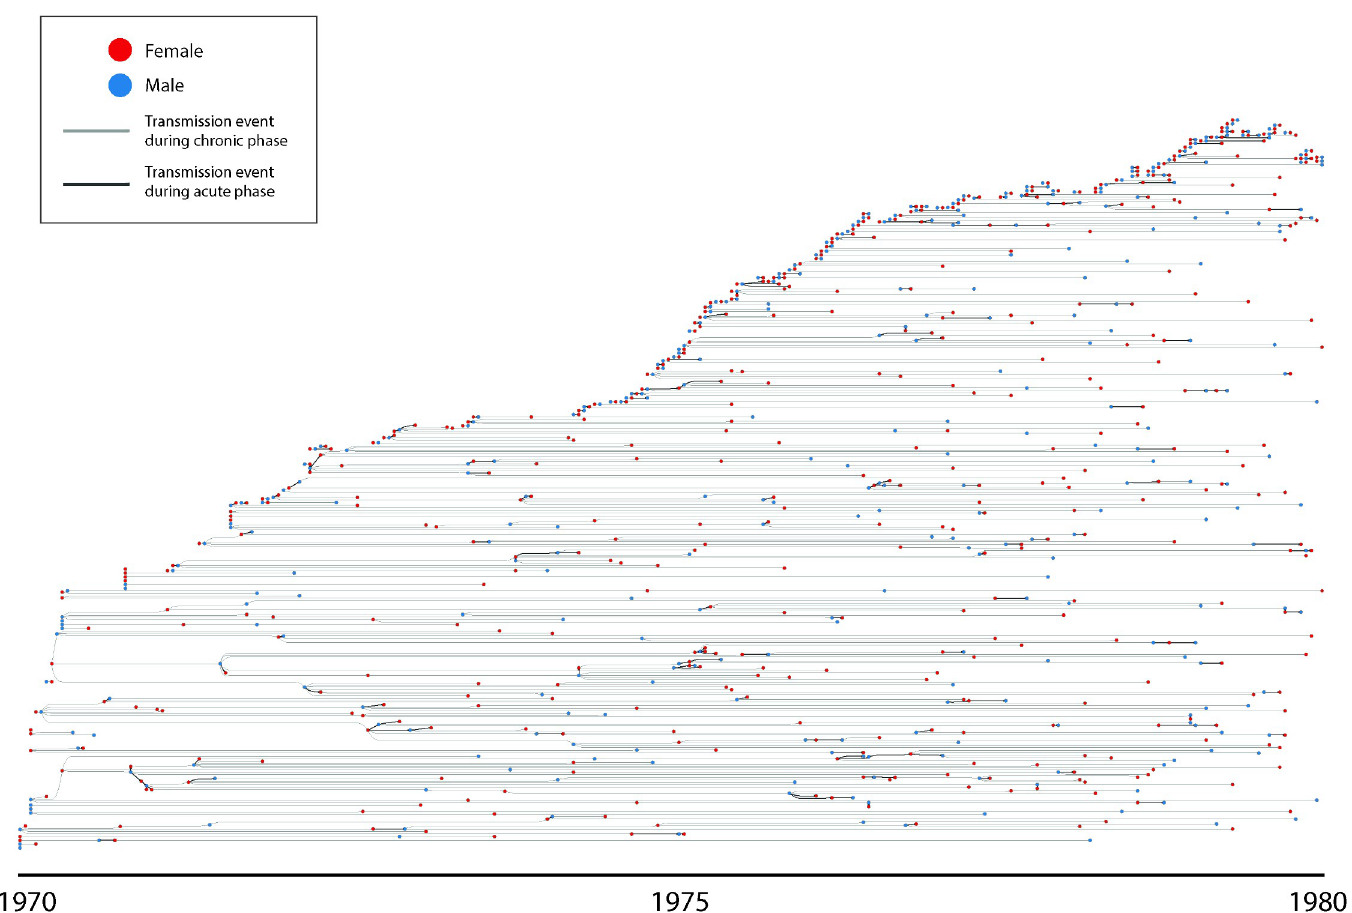
Fig 7. Transmission tree from a single calibrated run of the PopART-IBM over the period 1970–1980. Nodes (circles) represent HIV infected individuals, and are coloured by sex. Edges (straight lines) represent transmission events, with infectors on the left and infectees on the right. Thicker lines represent where infections occurred when the infector was in the early stages of HIV